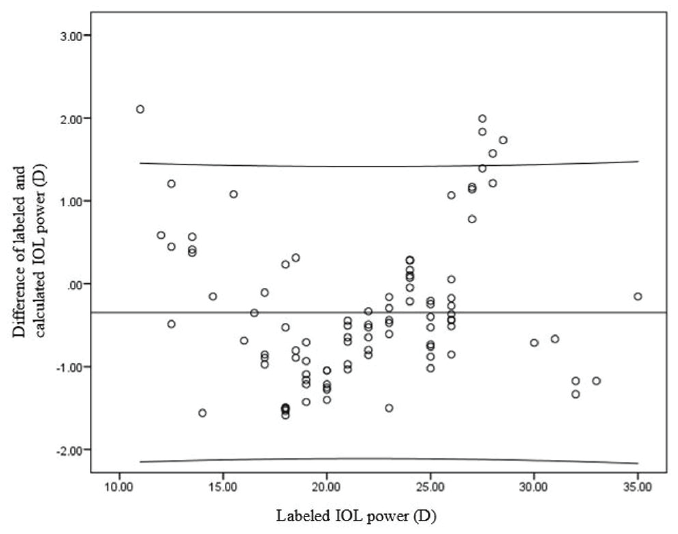
Figure 4. Plot of difference of labeled and calculated IOL powers against actual IOL power. The majority of labelled IOL powers lie within Mean ± SD of difference of labeled and calculated IOL